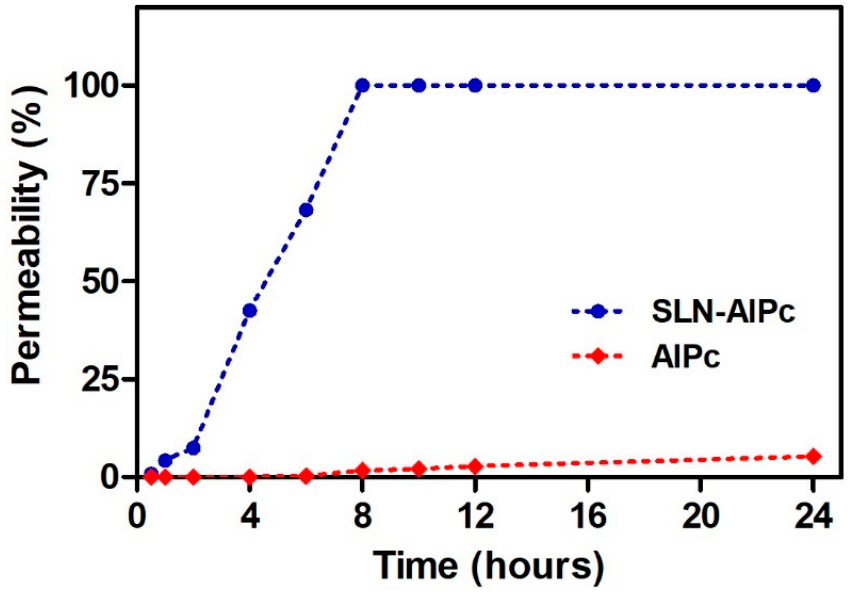
Figure 4. In vitro skin permeation profile of AlPc and SLN-AlPc over 24 h.